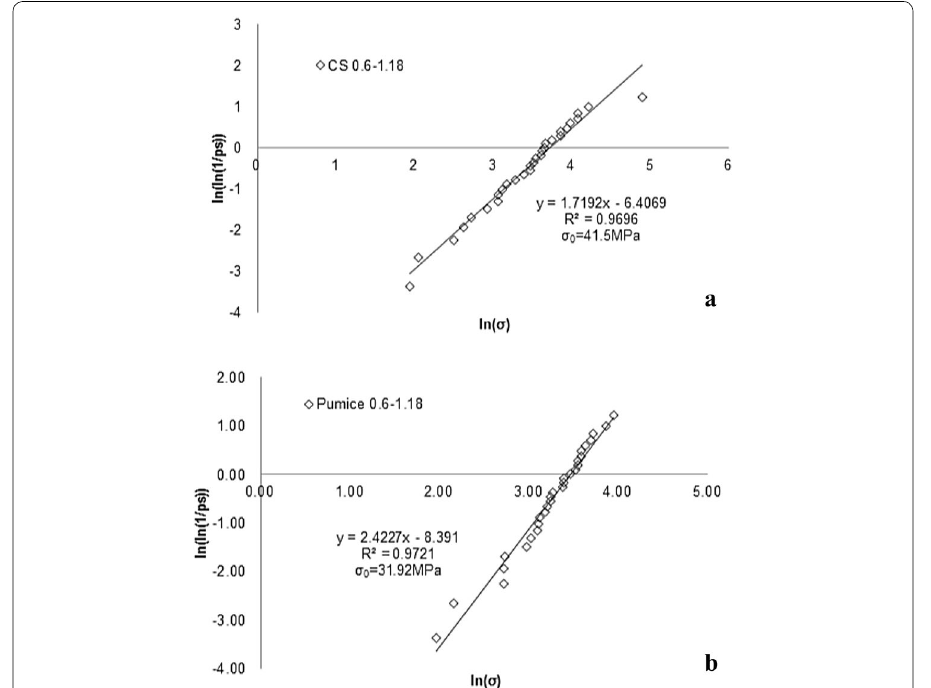
Fig. 6 The 37% survival possibility strength of CS and